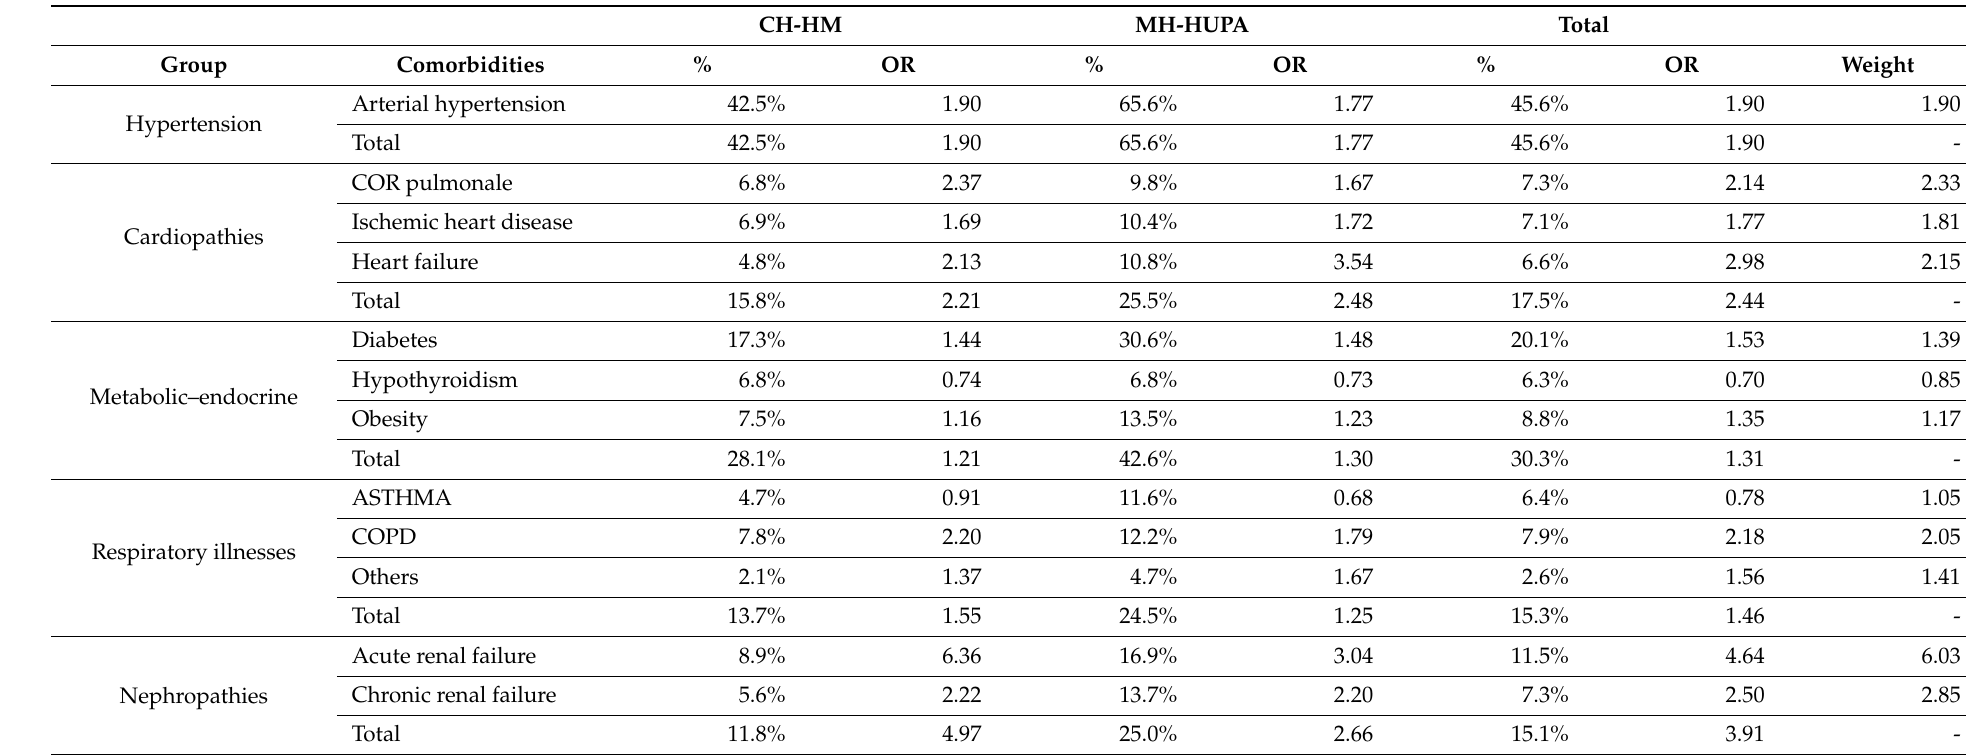
, where OR C is the odds ratio of 130 = 130